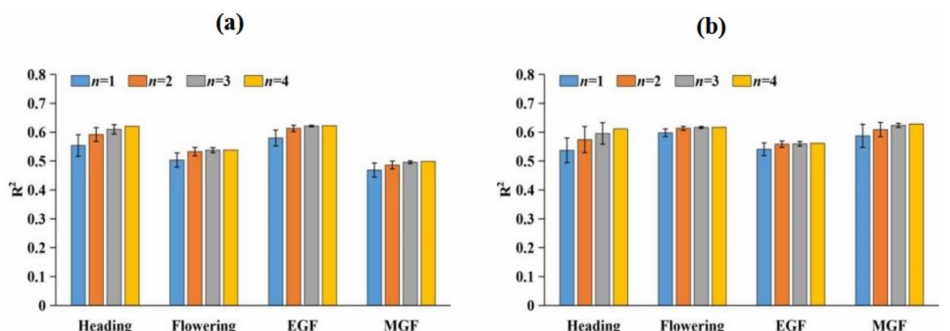
Figure 10. The overall prediction accuracy ( R 2 ) when stacking regression including different number of base learners; ( a ) under full irrigation treatment; ( b ) under limited irrigation treatment; when n is 1, it represents the overall accuracy of the four base learners; the bars represent the standard deviations. Abbreviations: EGF, early grain filling and MGF, mid-grain filling